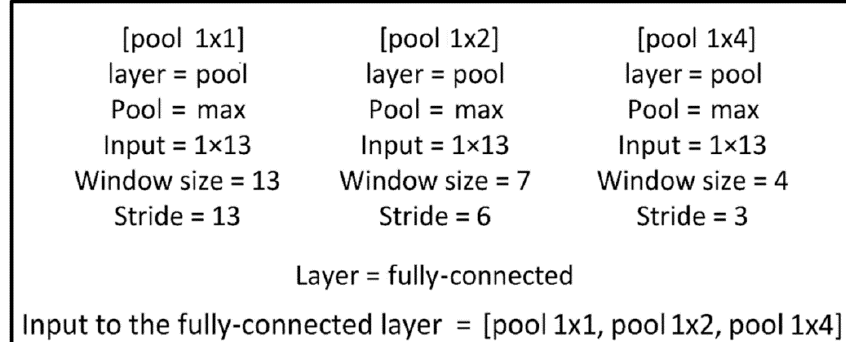
Figure 2 . A three-level pooling (1 × 1, 1 × 2, and 1 × 4) for one feature vector (a size of 1 × 13).